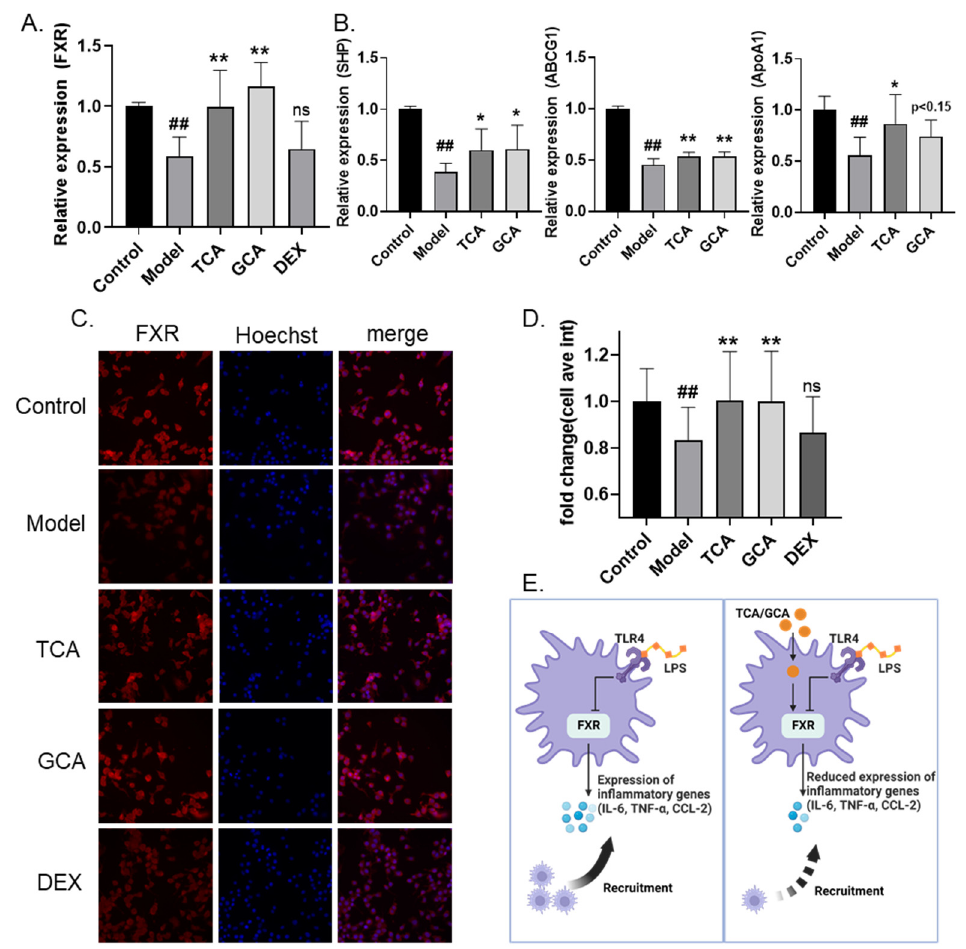
Figure 6. TCA and GCA increase the expression of FXR. ( A ) Increased FXR mRNA levels in bile acids-supplemented macrophage inflammation model. ( B ) Increased FXR downstream genes mRNA levels in bile acids-supplemented macrophage inflammation model. ( C , D ) Representative fluorescent images ( C ) and fluorescence quantification ( D ) of FXR immunofluorescence. ( E ) Schematic diagram of the proposed anti-inflammation mechanism of TCA and GCA. All the data are presented as the mean ± SEM of three independent experiments. # Compared with the control group; * compared with the model group; *, p < 0.05, ## or **, p < 0.01.